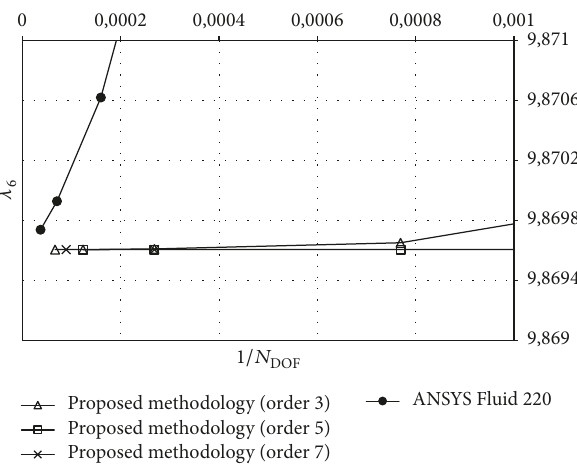
̂𝜆 1/𝑁 6 versus DOF